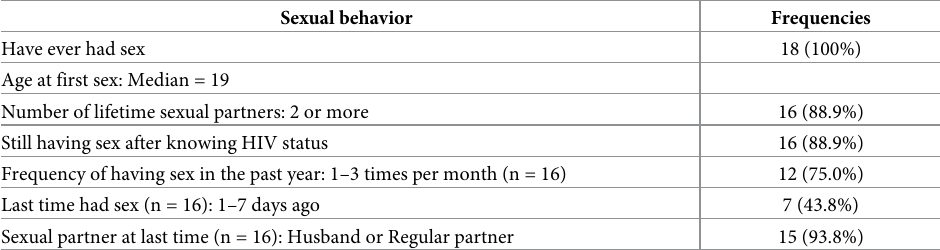
Table 2. Sexual behavior of female Shan living with HIV (N = 18).